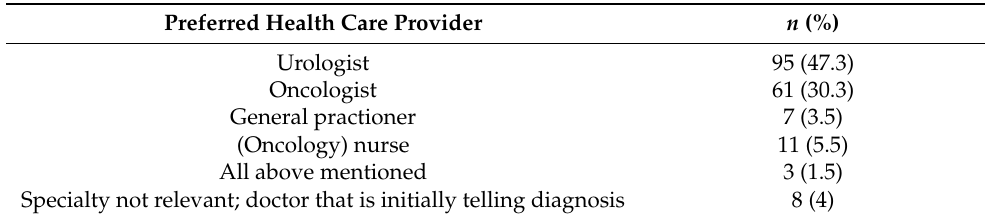
Table 3. Patient preferred a health care provider for counselling on treatment related fertility